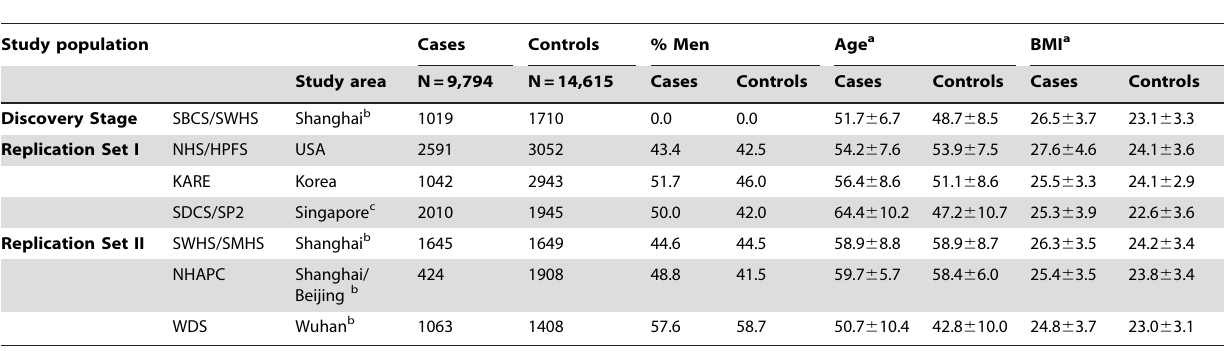
Table 1. Characteristics of the study